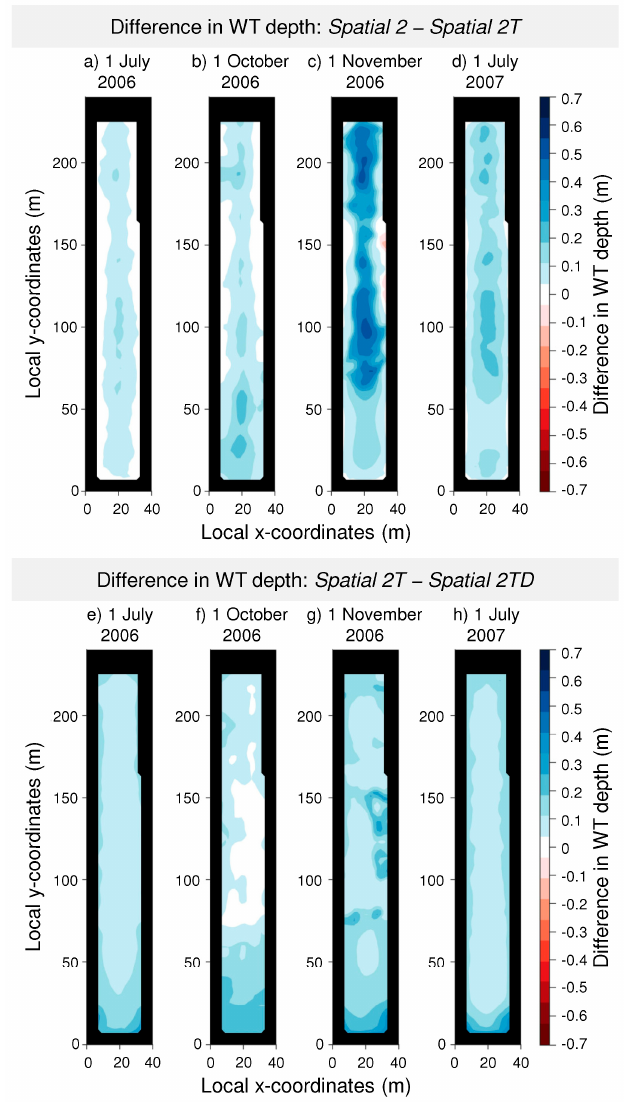
Figure 7. The difference in water table (WT) depth influenced by tree stand thinning ( a – d : Spatial 2–Spatial 2T ) and reduced drainage efficiency ( e – h : Spatial 2T–Spatial 2TD ). The darker blue the area, the higher the WT within the thinned stand or with the reduced drainage efficiency.